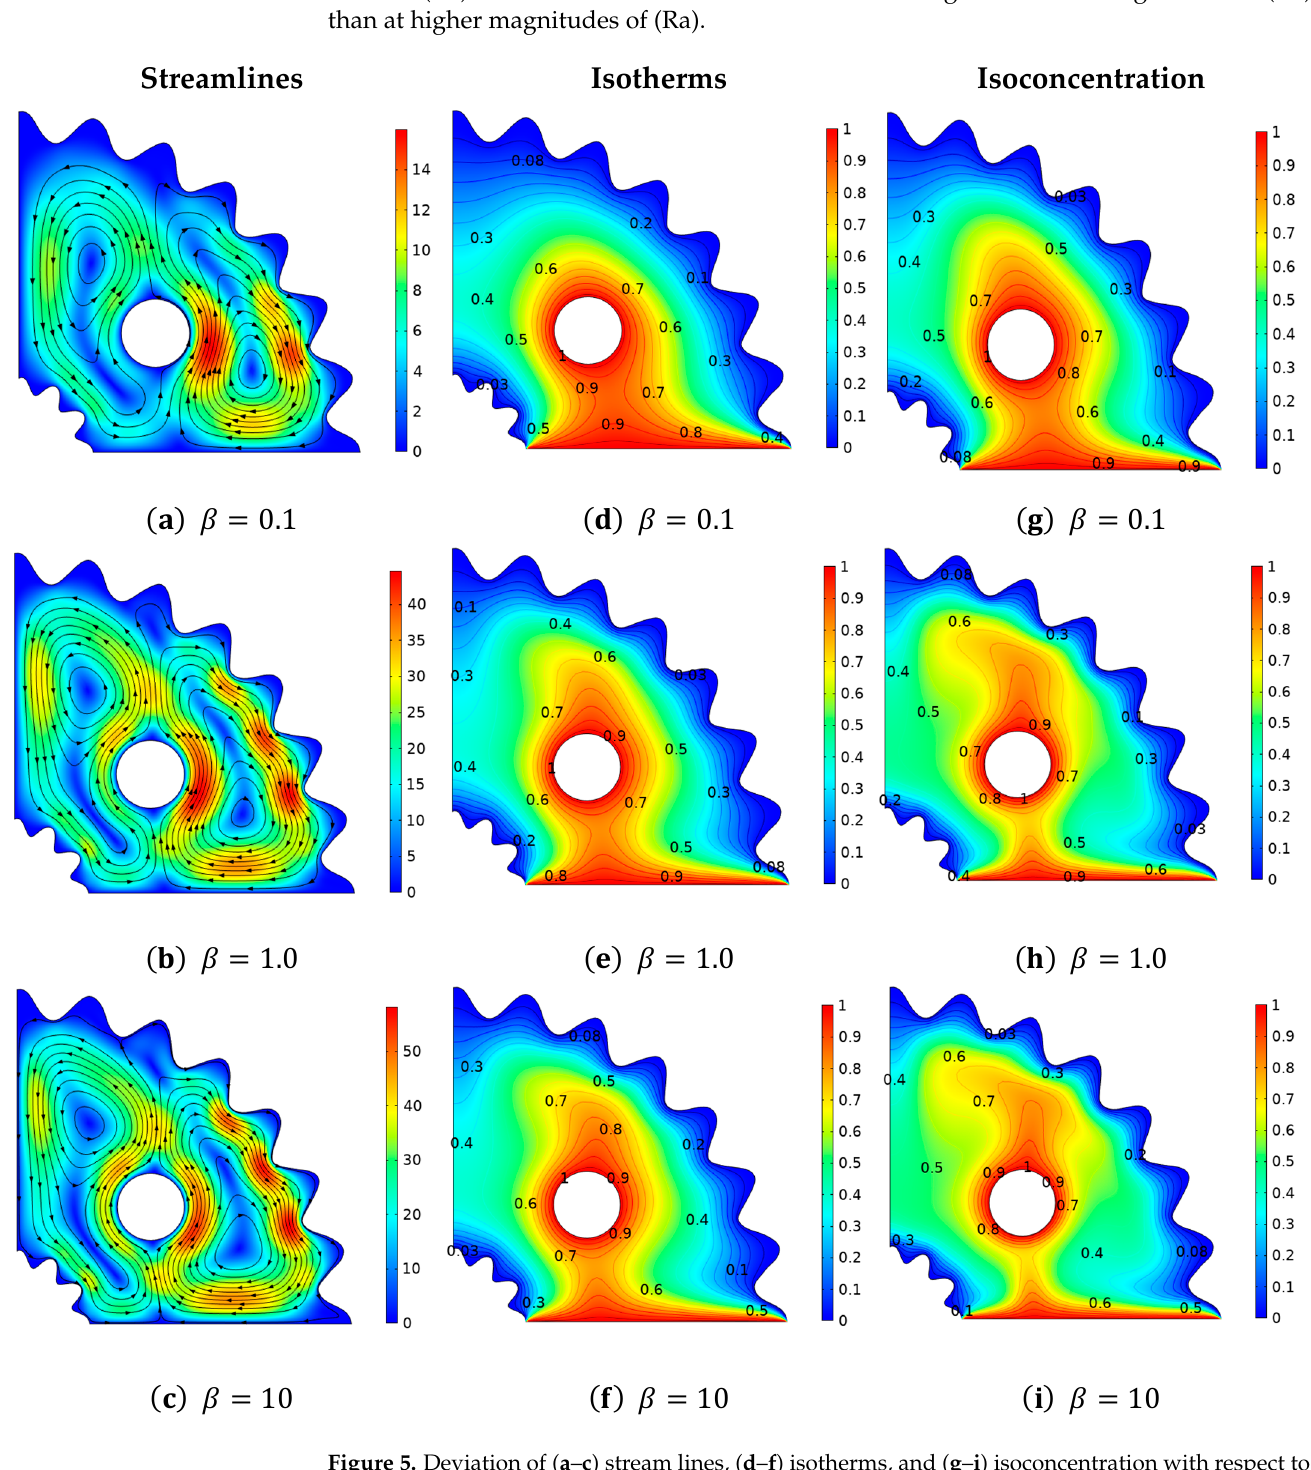
Figure 5. Deviation of ( a – c ) stream lines, ( d – f ) isotherms, and ( g – i ) isoconcentration with respect to the Casson parameter ( β ).